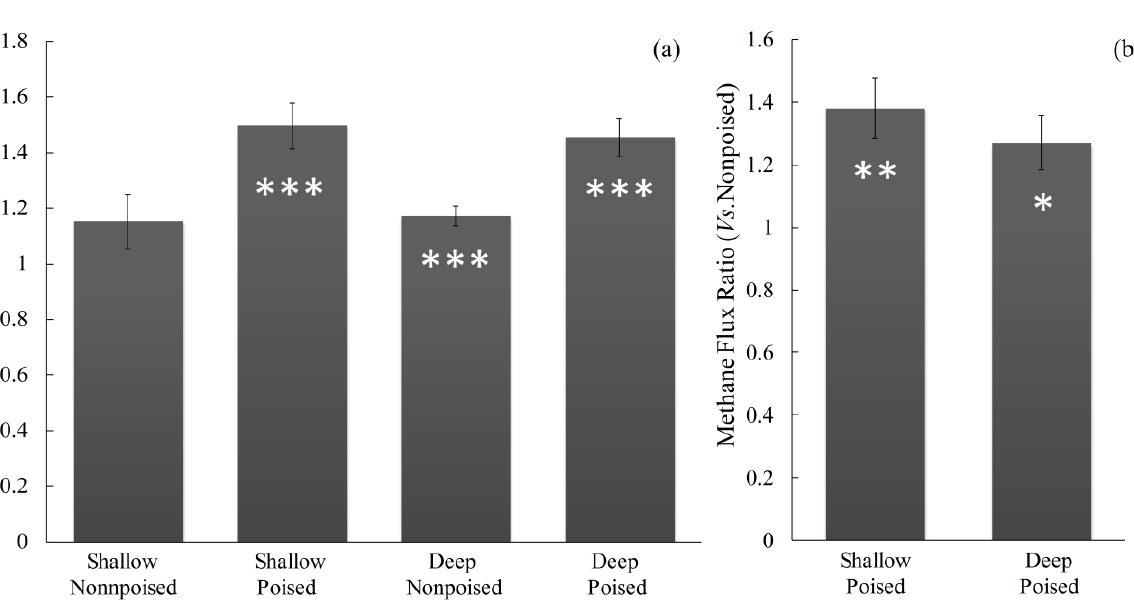
Figure 2. Average ( a ) methane flux ratios for the chambers with electrodes vs. the control chambers and ( b ) for the chambers with poised electrodes vs. those with nonpoised electrodes. Ratios were calculated on each measurement day to account for temporal variations in methane flux based on temperature, precipitation, and other variables. The values shown in the graphs represent the average methane flux ratio over the course of the experiment, and error bars indicate standard error. Significant differences at p = 0.05 (*), p = 0.01 (**), and p = 0.001 (***) using Bonferroni correction are